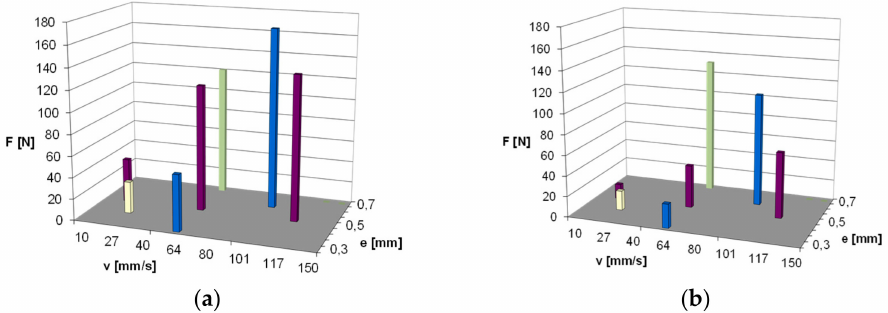
Figure 5. Maximum values of friction force obtained for particular points of the experimental designs: ( a ) NBR pure material; ( b ) NBR material with graphite filler.